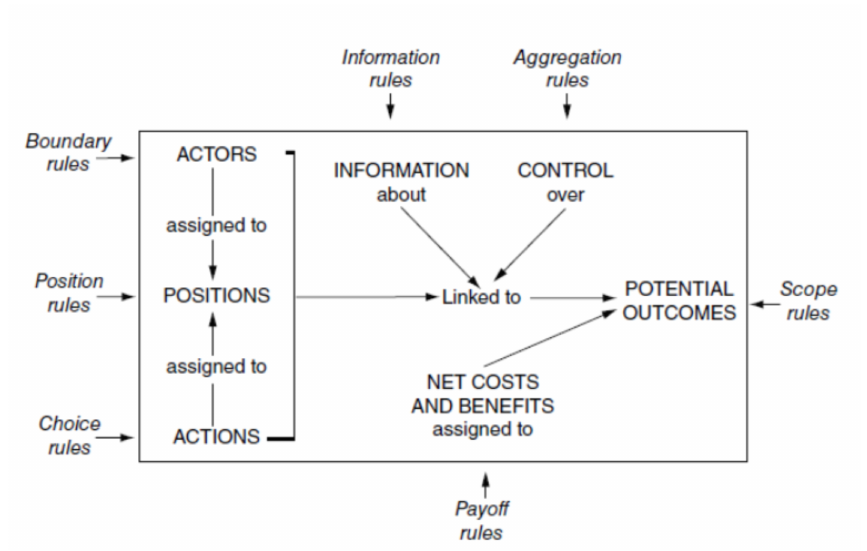
Figure 1. Rules-in-use affecting the structure and elements in an action-situation as developed by Ostrom